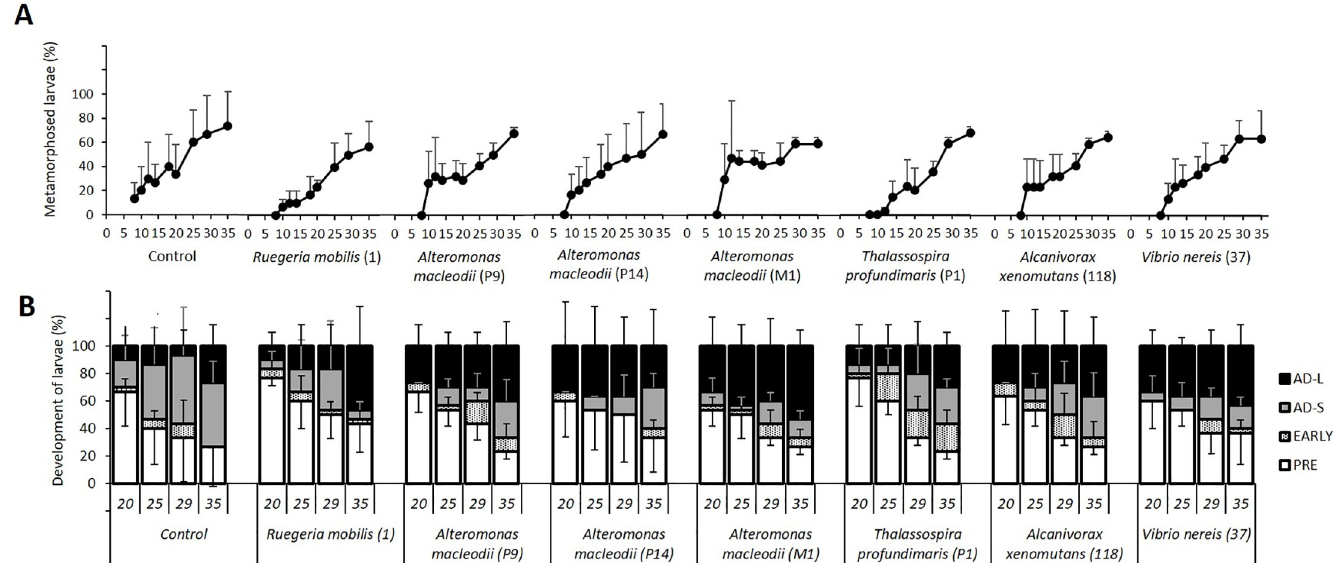
Fig 6. The effect of native bacteria (10 3 CFU mL -1 ) on the metamorphosis of Rhytisma fulvum fulvum coral planulae. Planulae harvested in 2016 were maintained with water exchange on alternative days and under a 12L:12D h photoperiod condition. All planulae were alive after 35 days of incubation. A. Total metamorphosed planulae on days 8, 10, 12, 14, 18, 20, 25, 29 and 35 of the experiment. B. Developmental stages on days 20, 25, 29 and 35. Planulae were classified into four stages: pre- metamorphosis (open bars), early metamorphosis (stippled bars); advanced metamorphosis with short tentacles (grey bars); and advanced metamorphosis with long tentacles (black bars). Data are presented as means ± S.D, n = 3, 10 individuals per